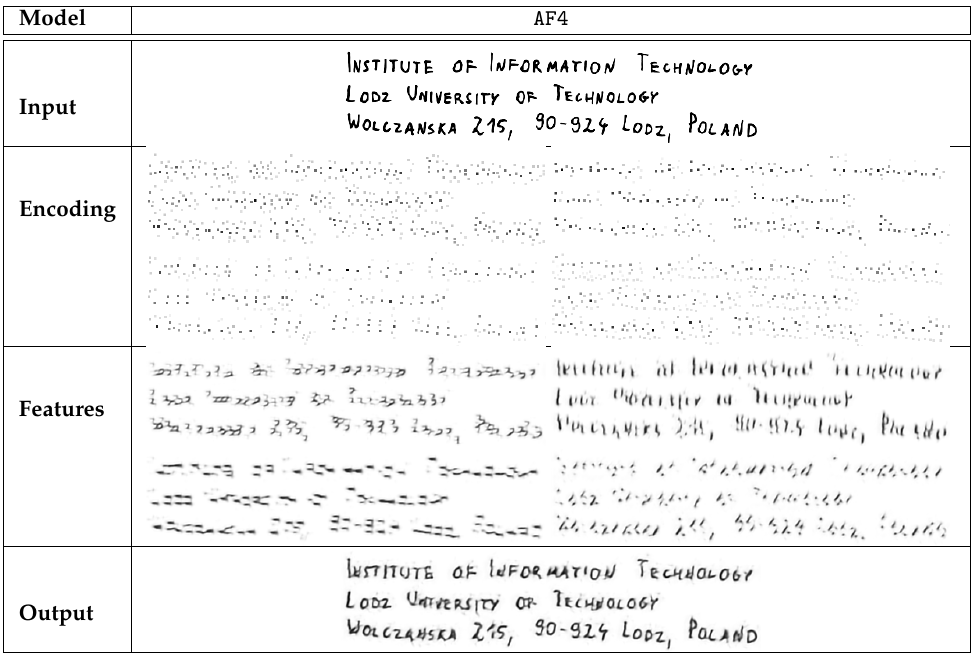
Figure 15. Sample encoding of a postal address scan that contains both digits and letters, performed with the AF4 model. The presented feature-specific decodings were generated in the same way as those shown in Figure 8.